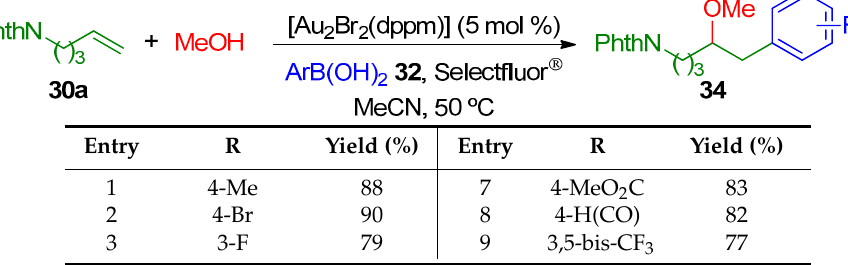
Table 2. Methoxyarylation with different ArB(OH) 2 32 .